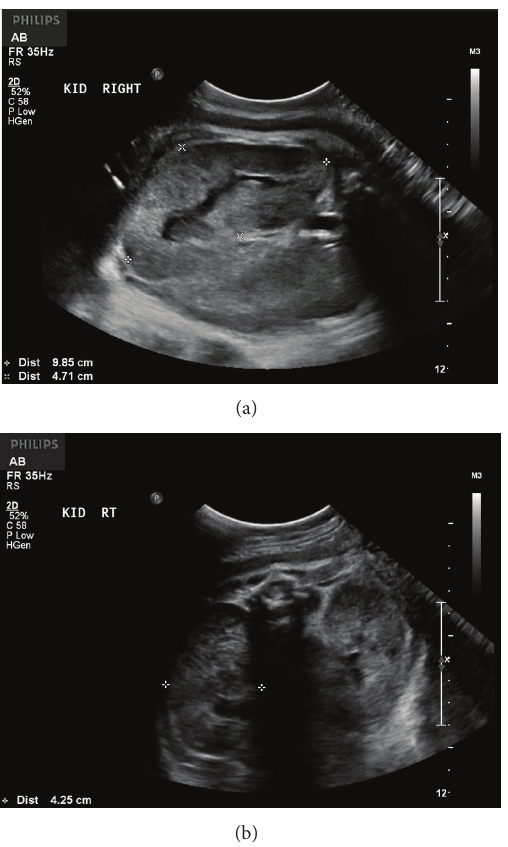
Figure 2: (a) Longitudinal images of the fetal kidneys at 29 weeks and 1 day of gestation. The kidneys continue to be enlarged and echogenic in appearance. Oligohydramnios was noted at the time of this ultrasound. (b) Transverse images of the fetal kidneys at 29 weeks and 1 day of gestation.